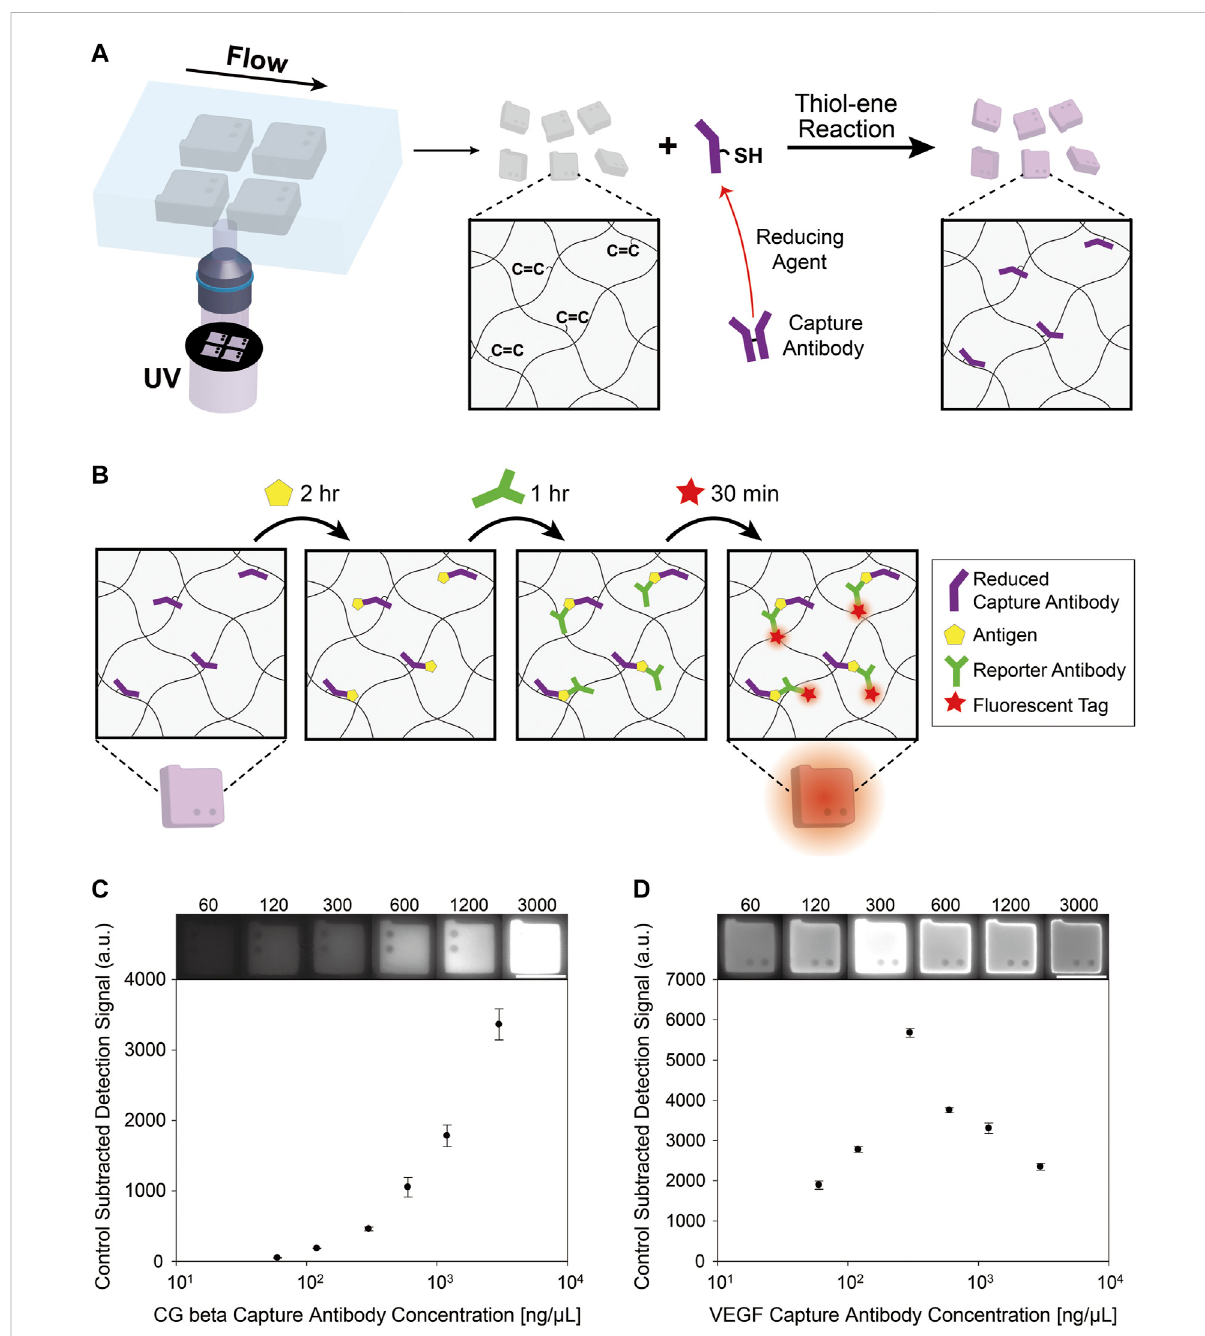
FIGURE 1 (A) Synthesis of encoded hydrogel microparticles with stop- fl ow lithography. Conjugation of thiol groups of the reduced antibody to the unreacted acrylate groups of the encoded hydrogel particles by thiol-ene reaction. (B) The detection process of protein antigen utilizing capture antibodyconjugatedhydrogelmicroparticles.Theparticlesareincubatedwiththetargetproteinfor2 h.Then,abiotinylatedreporterantibodybinds to thetarget. After thereporter antibody isattached,the fl uorescentlabel,streptavidin-phycoerythrin (SA-PE) binds to thereporter antibody by streptavidin-biotin interaction. (C) Control-subtracted detection signals of hydrogel particles after immunoassay varying concentrations of CG beta captureantibodiesduringpost-synthesisfunctionalization. (D) Control-subtracteddetectionsignalsofhydrogelparticlesafterimmunoassayvarying concentrations of VEGF capture antibodies during post-synthesis functionalization. The scale bars are 100 μ